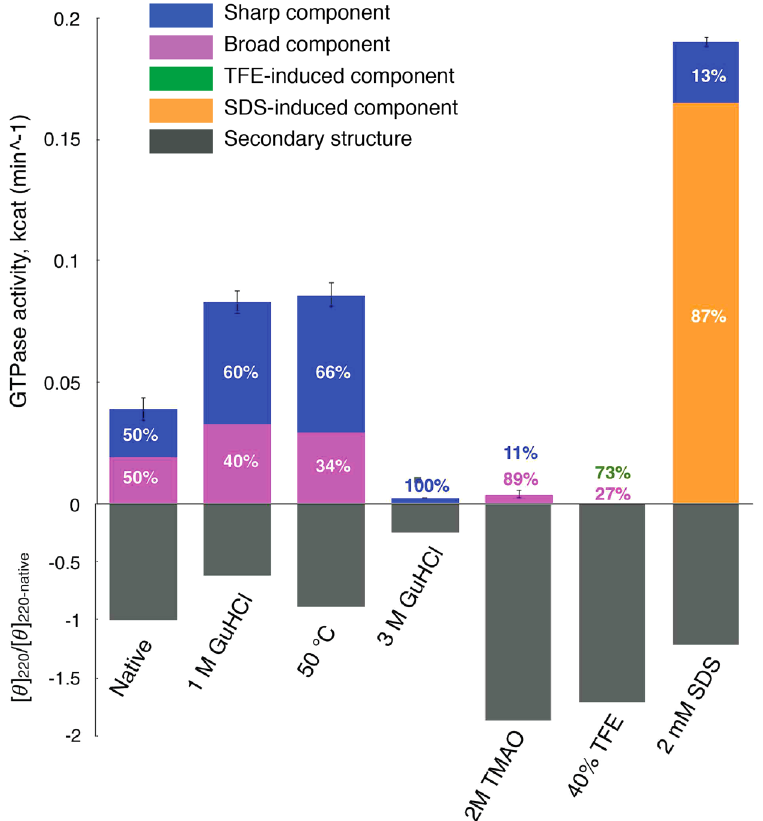
Figure 4. Correlation between the GTPase activity of Sp UreG and its structural features. The turnover number, measured with a malachite-green colorimetric assay, is reported under the addition of different additives or at different temperatures, as indicated in the figure. The error bars were calculated as the standard deviations of three replicates. The conformational distribution is plotted in terms of the relative amount of the conformations obtained from SDSL-EPR experiments, and of the content in secondary structure calculated as the ratio between the negative mean residue ellipticity, measured at 220 nm for each condition, and its absolute value measured for the native